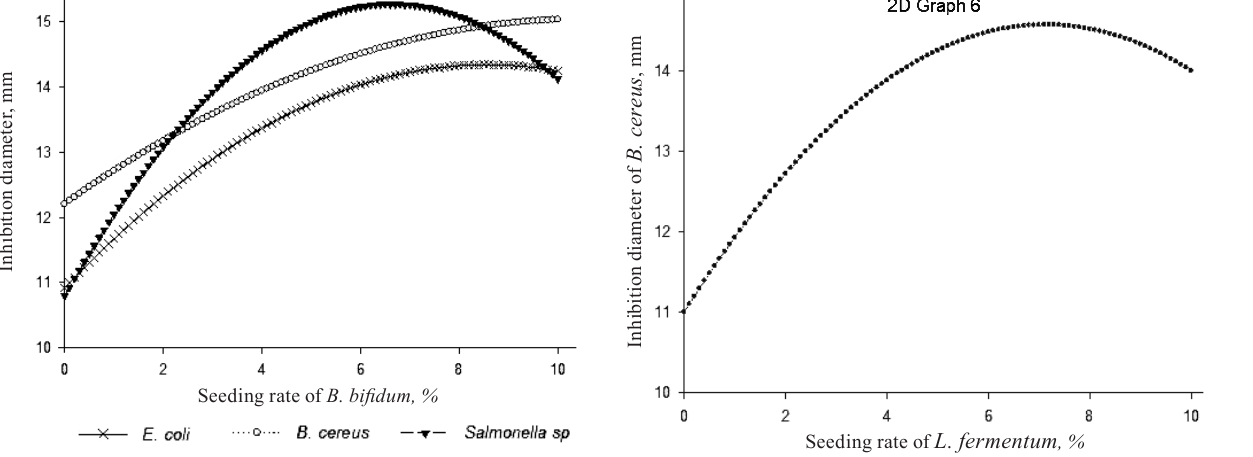
Figure 3 Individual effect of Lactobacillus fermentum on Bacillus